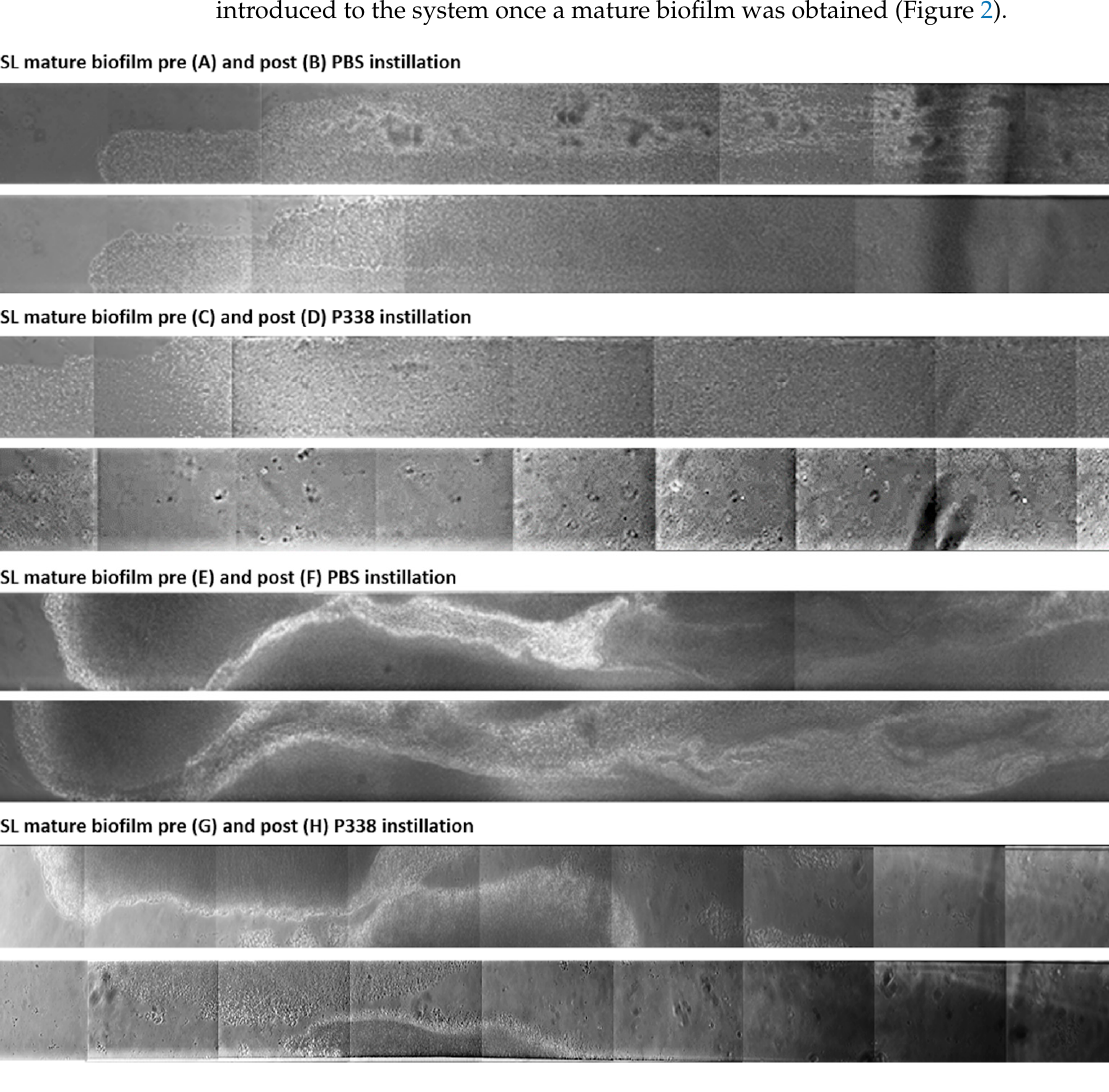
Figure 2. P338 disrupts biofilm biomass in a urinary catheter in vitro model: Reconstruction of portions of viewing windows of the microfluidic channels containing the Ec5FSL and Ec9FSL biofilms immediately before ( A , C , E , G ) and after 6 h instillation of 1× PBS ( B , F ) or 0.5% P338 solution ( D , H ). Acquisition was performed with a 20×, 3.1 WD objective.